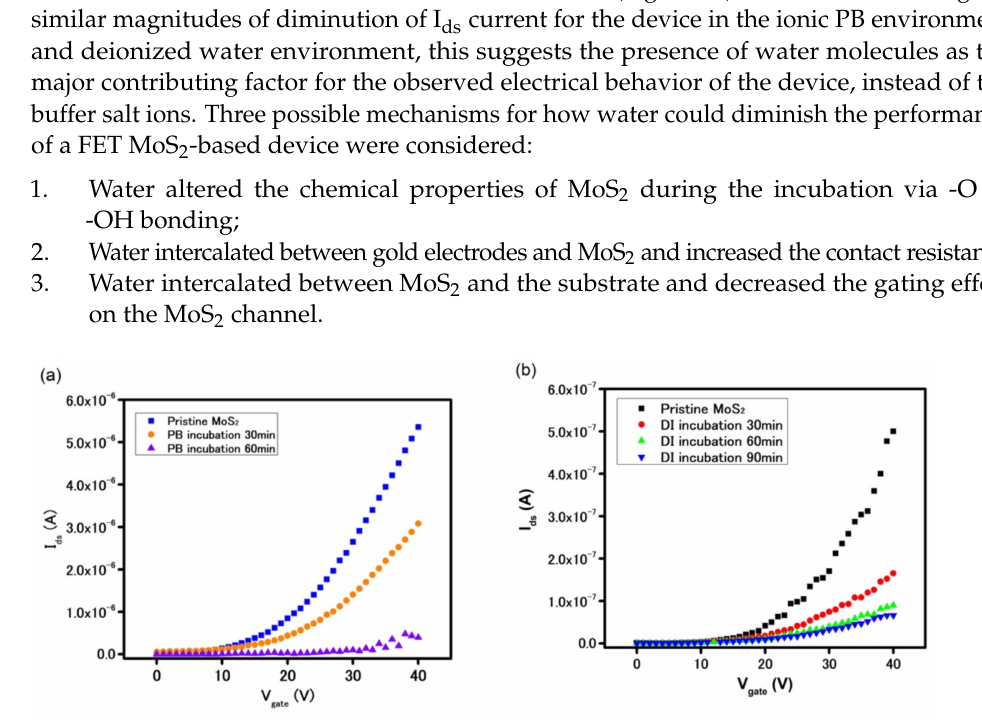
Figure 3. FET characteristics curve of MoS 2 -based device in ( a ) PB (pH = 7.4) and ( b ) DI water (pH =